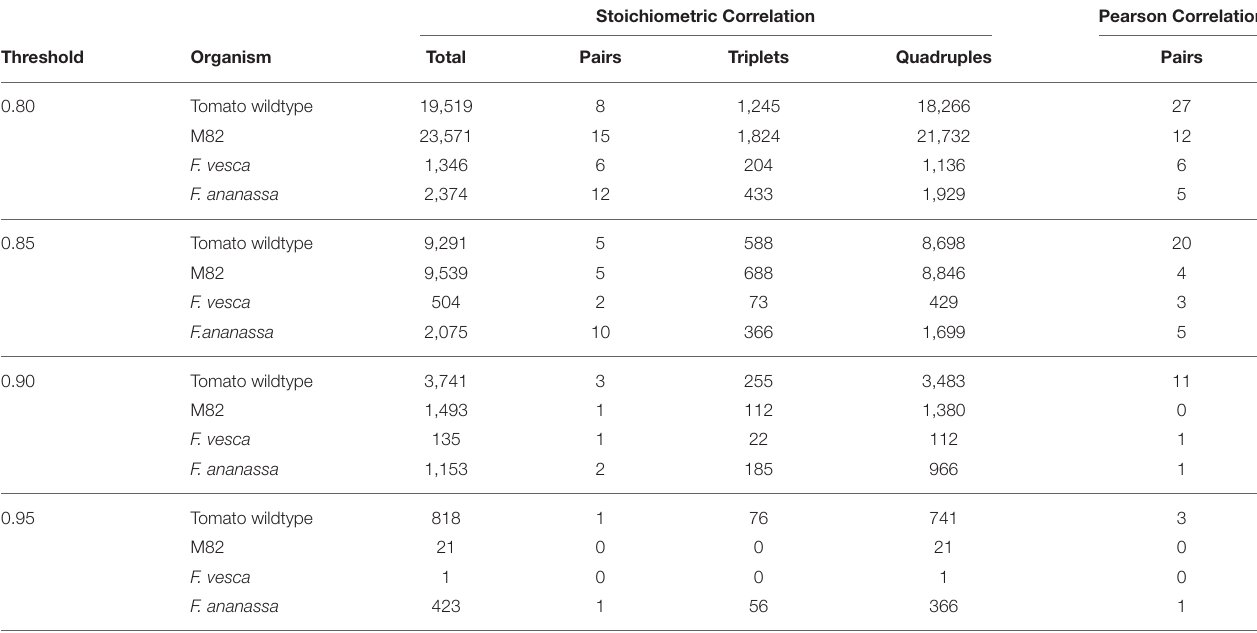
TABLE 2 | Overview of number of significant stoichiometric correlations at different thresholds for the considered tomato and strawberry species. Stoichiometric Correlation Pearson